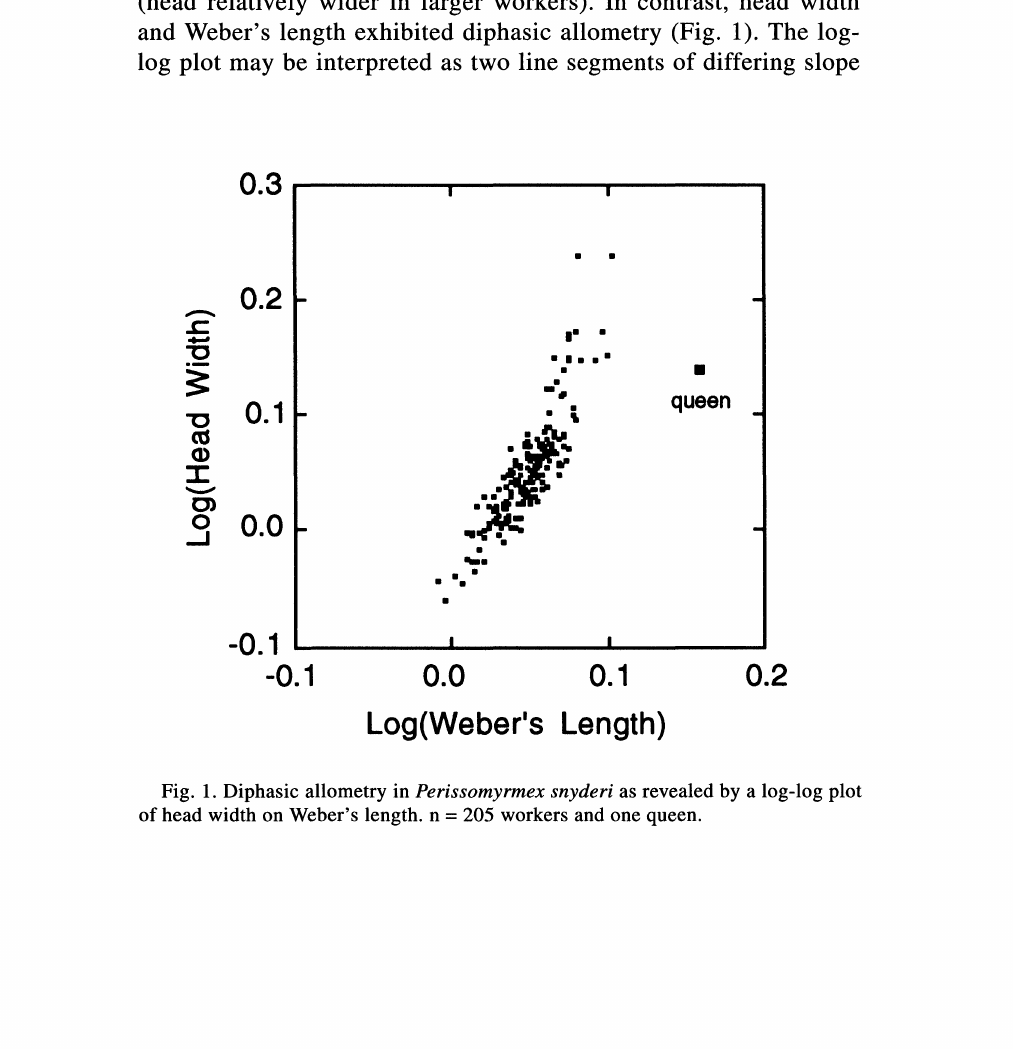
Fig. 1. Diphasic allometry in Perissomyrmex snyderi as revealed by a log-log plot of head width on Weber’s length, n 205 workers and one